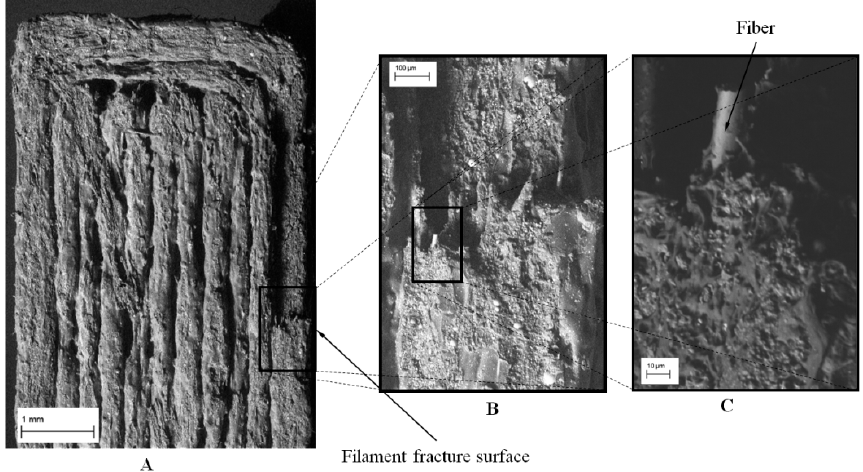
Figure 16. SEM images of Z-direction specimen—top view: ( A ) general view of the surface; ( B ) fracture surface of the contour line; ( C ) fiber rupture.